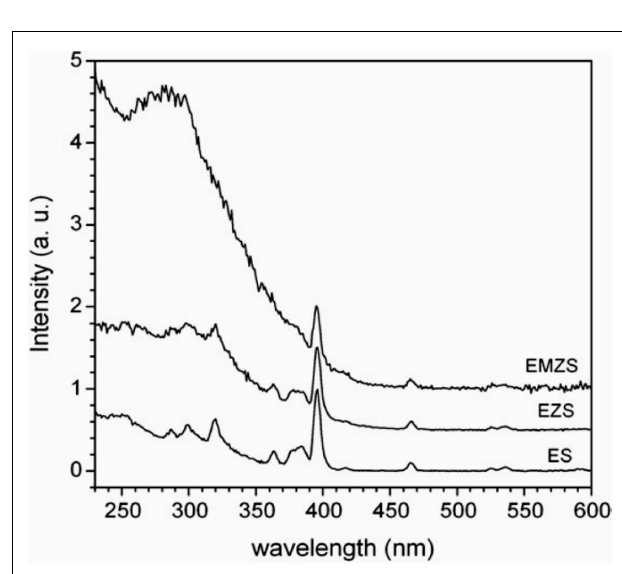
FIGURE 7 | Emission spectra of Eu 3 + -doped (EZS) and Eu 3 + , Mn 2 + -co-doped (EZMS) ZnS-SiO 2 samples annealed at 500 o C upon excitation at 280nm . Eu 3 + -doped SiO 2 (ES) and ZnS-SiO 2 (ZS) have been included as references (Planelles-Arago et al.,